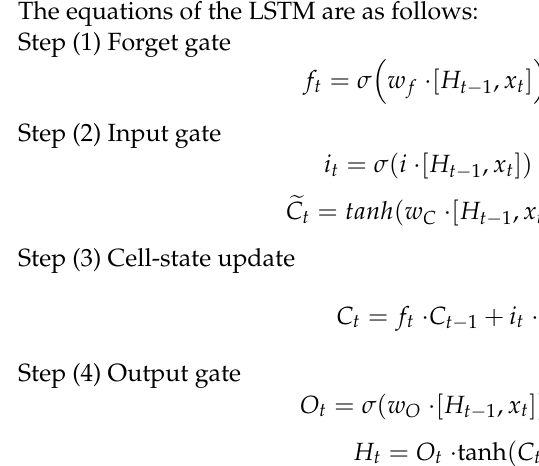
Figure 5. Structure of the LSTM.